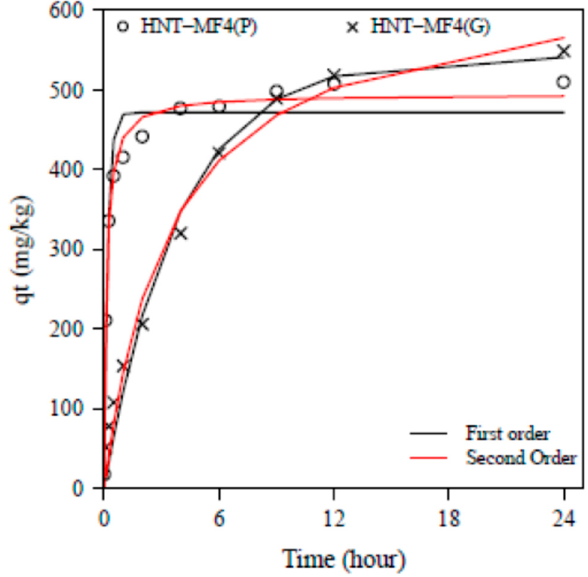
Figure 3. Phosphate adsorption kinetic data and optimized model equations for powder HNT-MF4(P) and granular form of HNT-MF4(G).